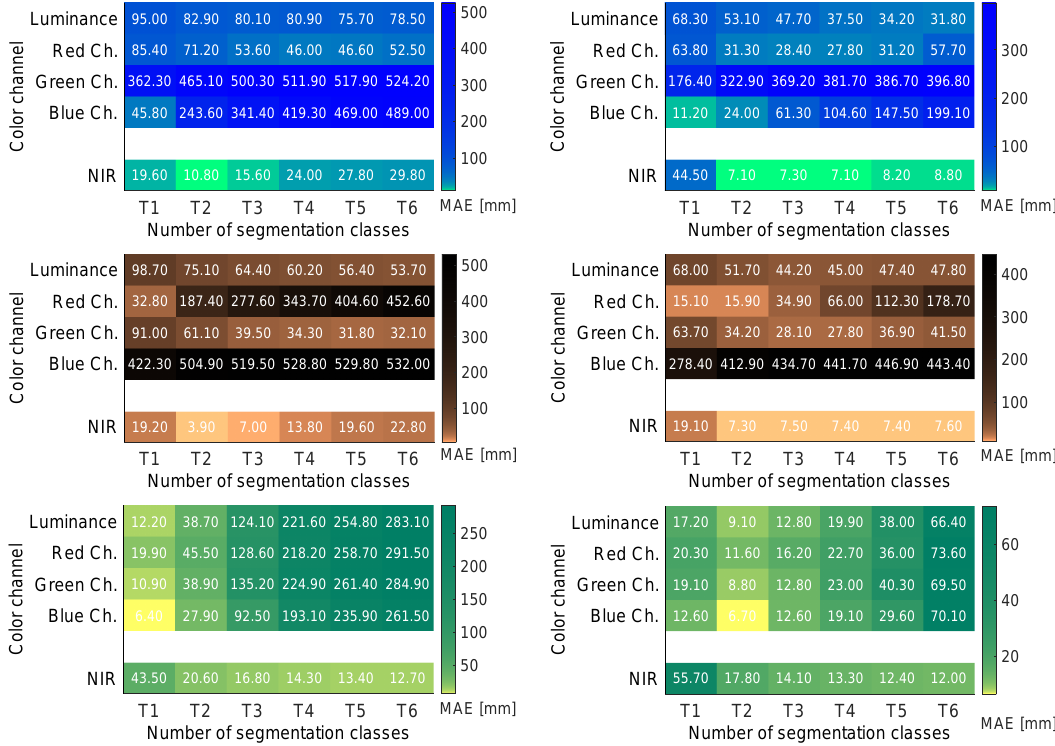
the blue channel is selected, whereas, in the narrow crop, the red channel is best for the RGB and the blue for the NIR pictures.